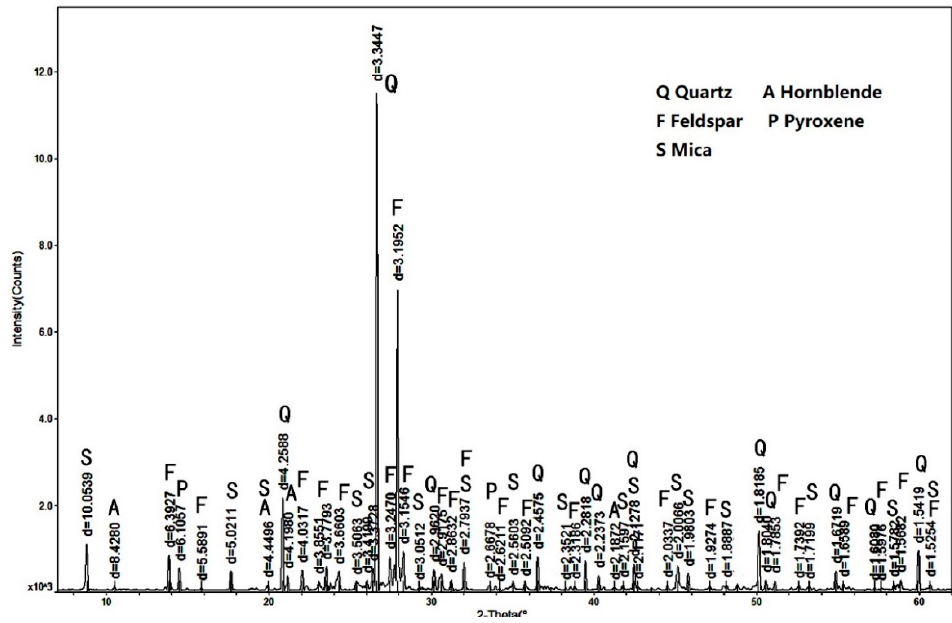
Figure 1. XRD analysis results of the sample.